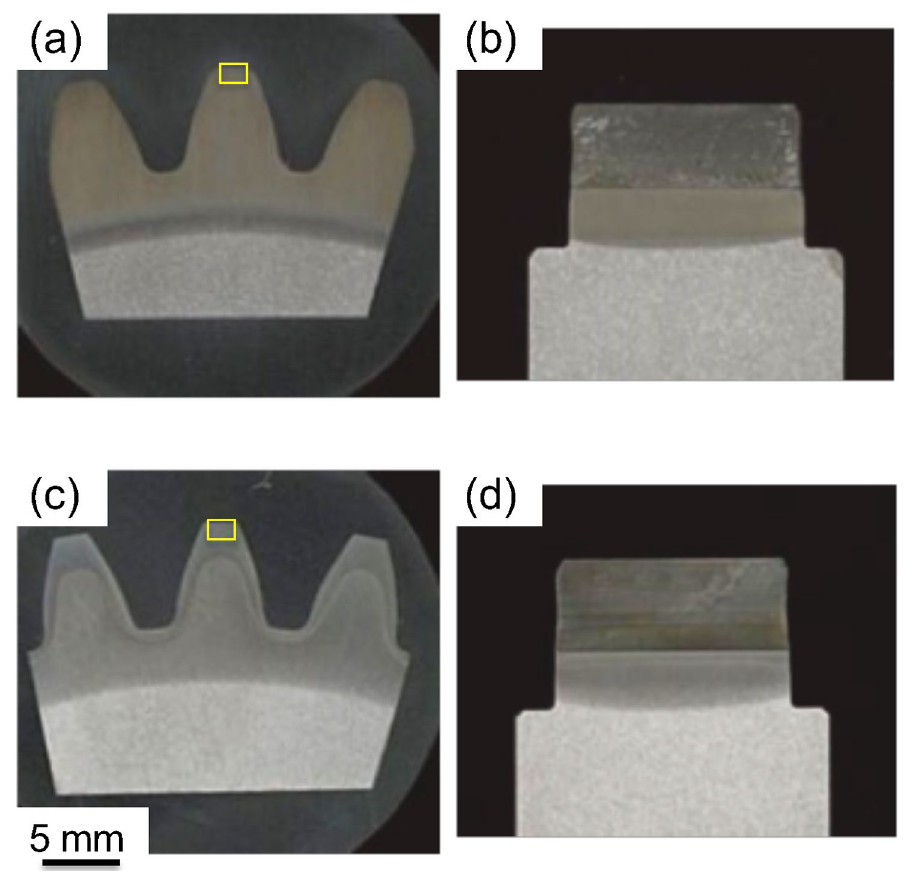
Figure 3. Optical micrographs showing the macrostructure of the tested gears: Sample 1 ( a , b ) and Sample 2 ( c , d ). ( a , c ) Obtained at the half gear thickness section observed from the axial (neutron transmission) direction and ( b , d ) were obtained for the gear tooth root plane observed from the hoop direction. The boxes in ( a , c ) indicate microstructure observation positions of each sample zooming in Fig. 5.